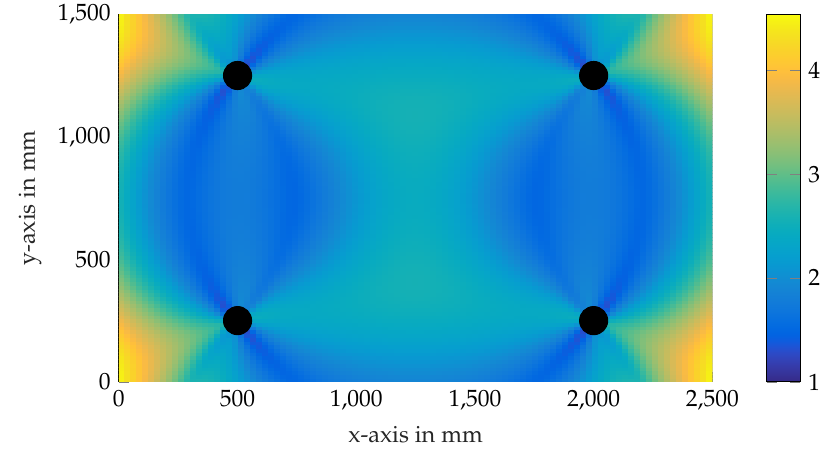
Figure 6. Normalized CRLB plot for a linearly-increasing measurement covariance function. Black markers depict the beacons.